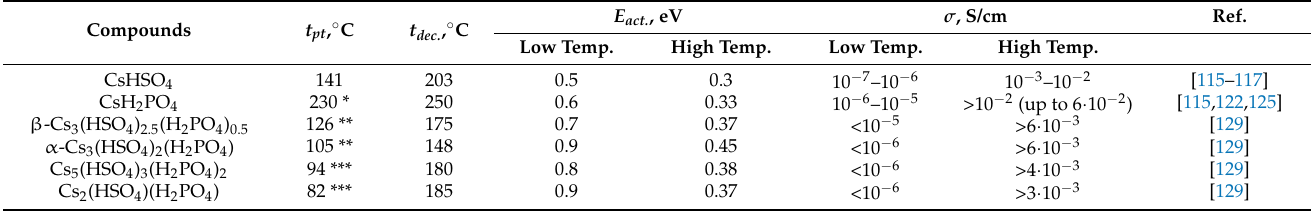
Table 13. Data of phase transition temperatures t pt , decomposition/melt t dec. , conduction activation energy E act. (low-temperature and high-temperature superionic phases), proton conductivity values σ (low-temperature and high-temperature superionic phases) in individual compounds based on CsHSO 4 -CsH 2 PO 4